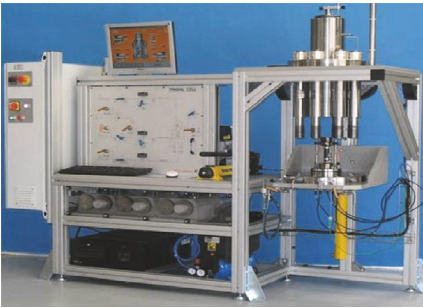
Figure 1: The rock servo-controlled rheology testing machine.